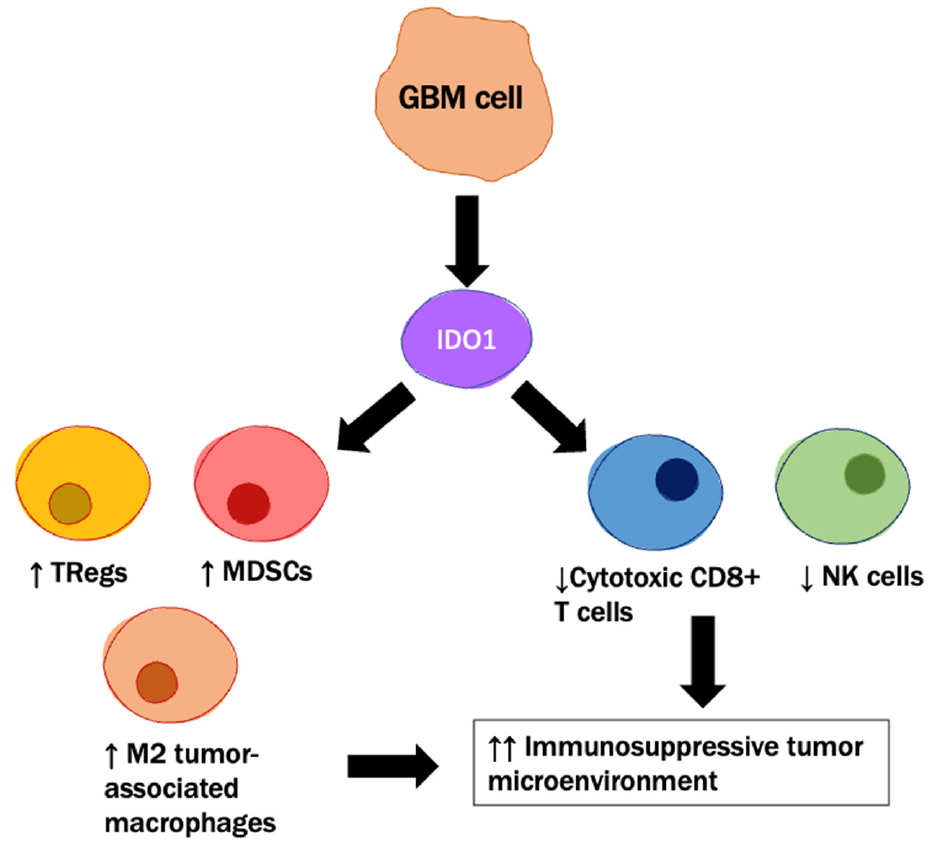
Figure 3. IDO1 promotes the immunosuppressive tumor microenvironment through multiple mecha- nisms. ↑ , ↑↑ = increased, ↓ = decreased.